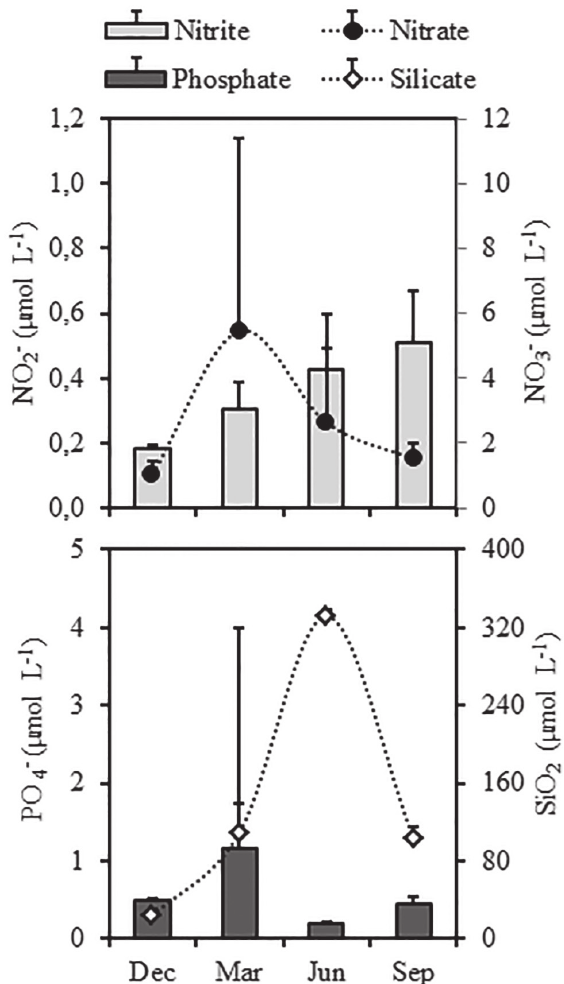
Figure 4 - Monthly average (±SD) concentrations of dissolved nutrients (µmol L -1 ) at Ajuruteua beach, Bragança, Pará: (A) nitrite and nitrate; (B) phosphate and silicate. vertical axes are plotted with different scales. Only positive deviation appears for variables with negative